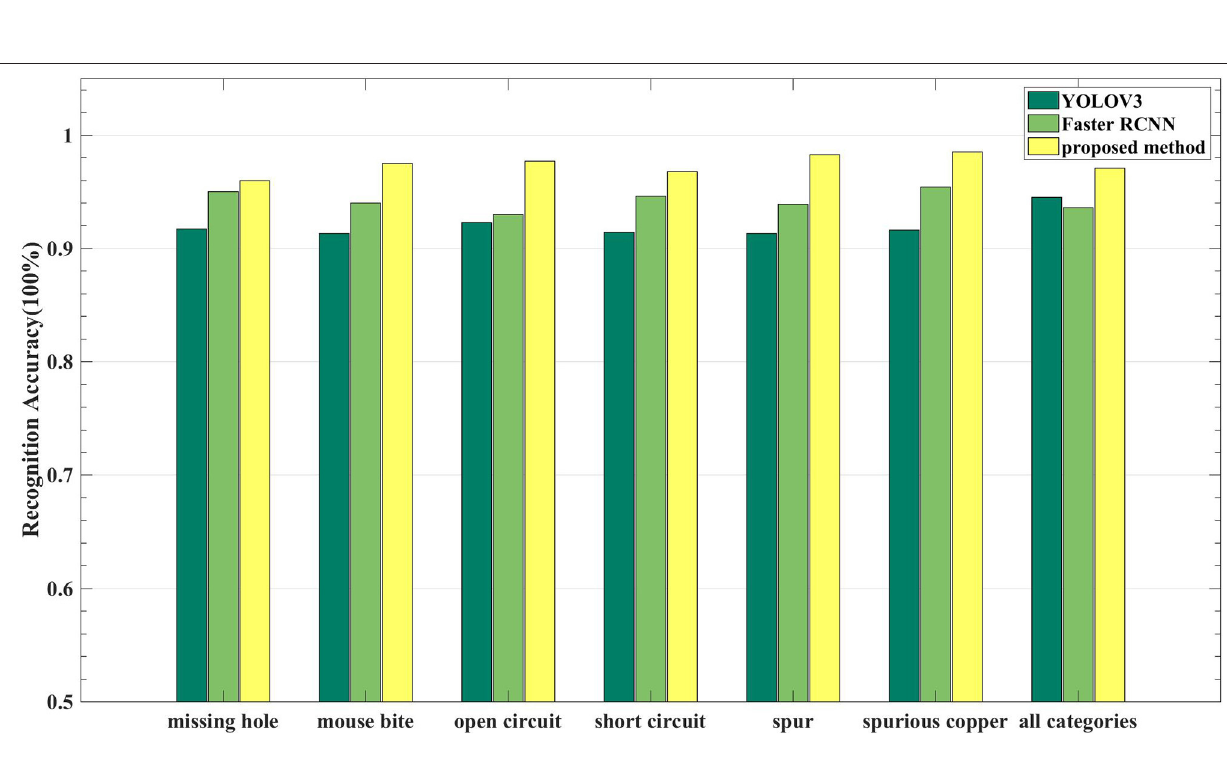
Focal loss is a new loss function to balance positive and negative samples, and its calculation formula is shown in